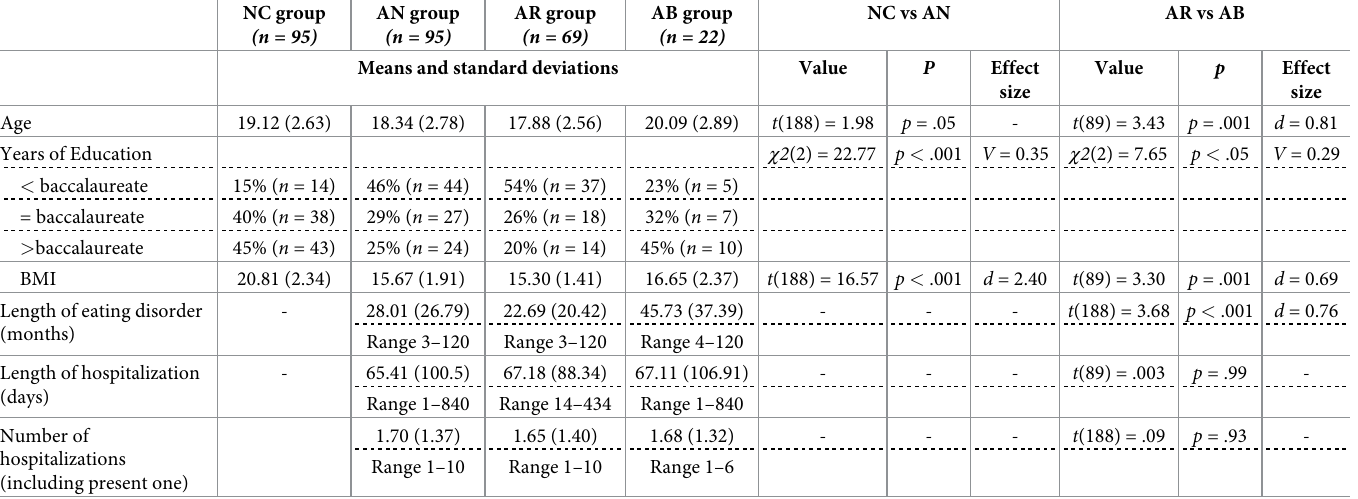
Table 1. Demographic characteristics of NC and AN